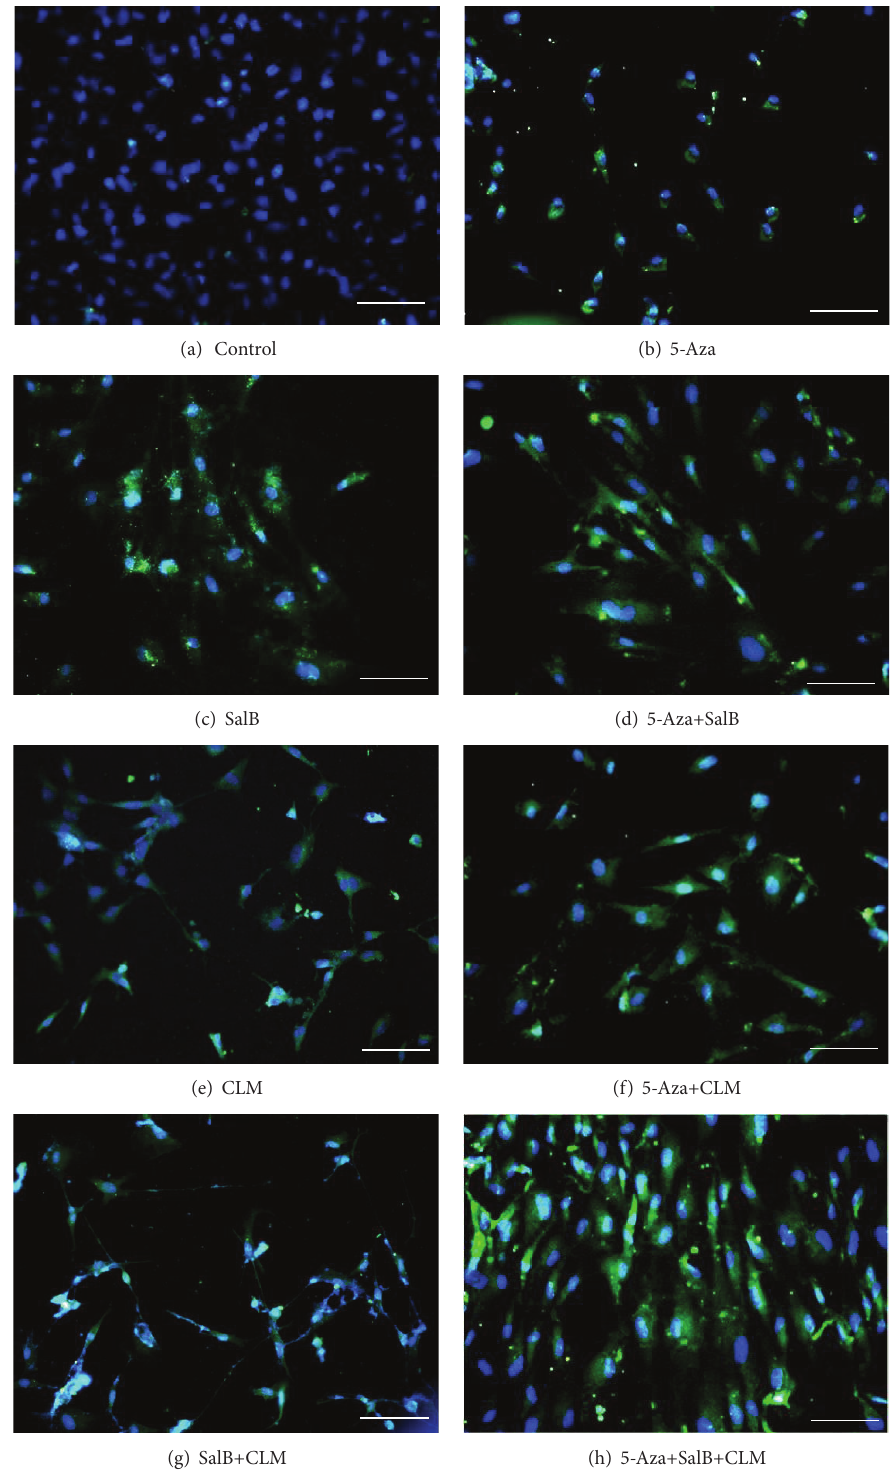
Figure 3: Immunofluorescence staining of cTnT in MSCs. After induction for two weeks, MSCs in each group were identified by immunofluorescence staining of cTnT. (a) Control group; (b) 5-aza group; (c) SalB group; (d) 5-aza+SalB group. (e) CLM group; (f) 5- aza+CLM group; (g) SalB+CLM group; (h) 5-aza+SalB+CLM group. Scale bar = 50 𝜇